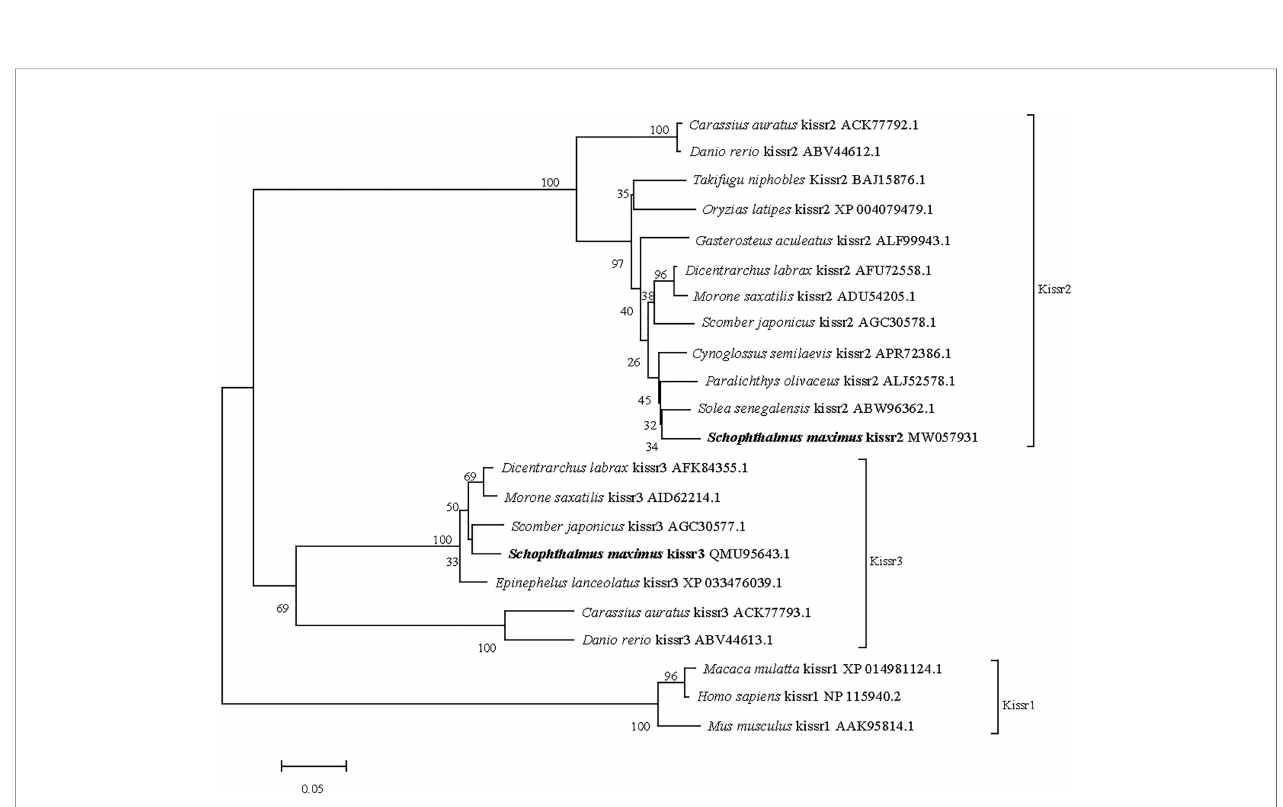
FIGURE 3 | Phylogenetic tree of deduced amino acid sequences of Kissr3 and Kissr2 from turbot and other vertebrates was constructed by Mega7 with neighbor- joining method. The bootstrap values at nodes indicate bootstrap percentage value for 1000 replicates (>80%). Relative branch lengths indicate the evolutionary rates of the lineages. The GenBank accession numbers of the sequences were presented after the species